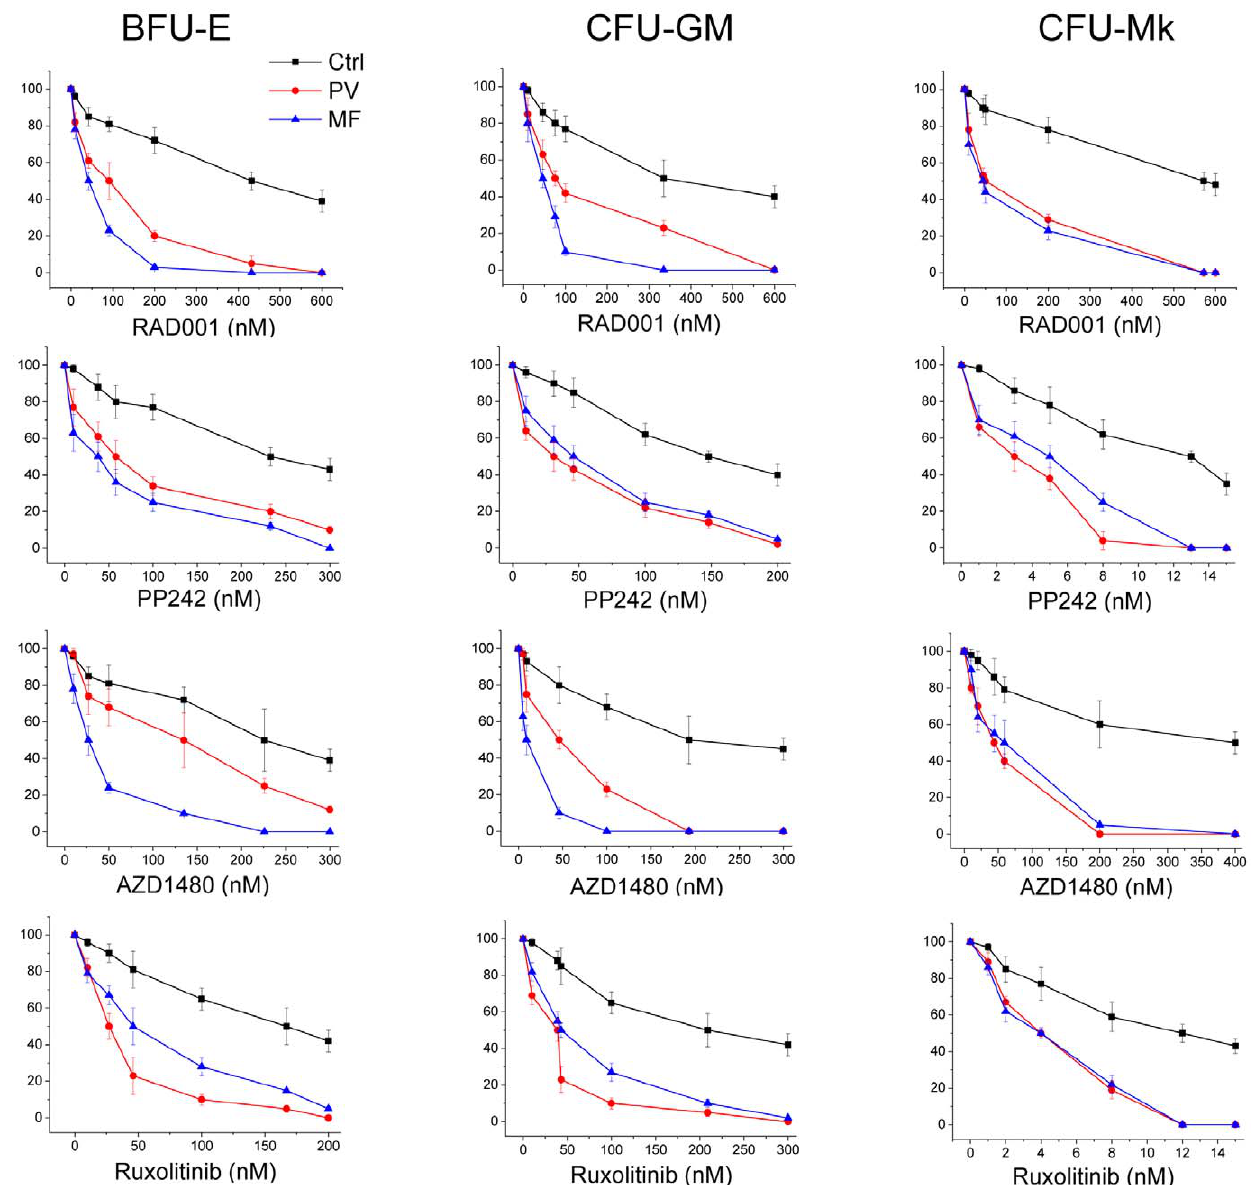
Figure 3. mTOR and JAK2 inhibitors preferentially suppress colony formation from hematopoietic progenitors of MPN patients as compared to healthy controls. Mononuclear cells from patients with PV or PMF (n=10 each) or control subjects (n=10) were plated at 10 5 /mL in cytokine-supplemented methylcellulose medium for the growth of erythroid burst-forming unit (BFU-E) and granulocyte-macrophage colony- forming unit (CFU-GM), and CD34 + cells (5 6 10 4 /mL) were plated in collagen-based medium for megakaryocyte colony-forming unit (CFU-Mk). Increasing amounts of mTOR inhibitors (RAD001 and PP242) or JAK2 inhibitors (AZD1480 and Ruxolitinib) were added at the beginning of culture. Colonies were enumerated on day 14 and expressed as a percentage of the colonies grown in control plates containing vehicle